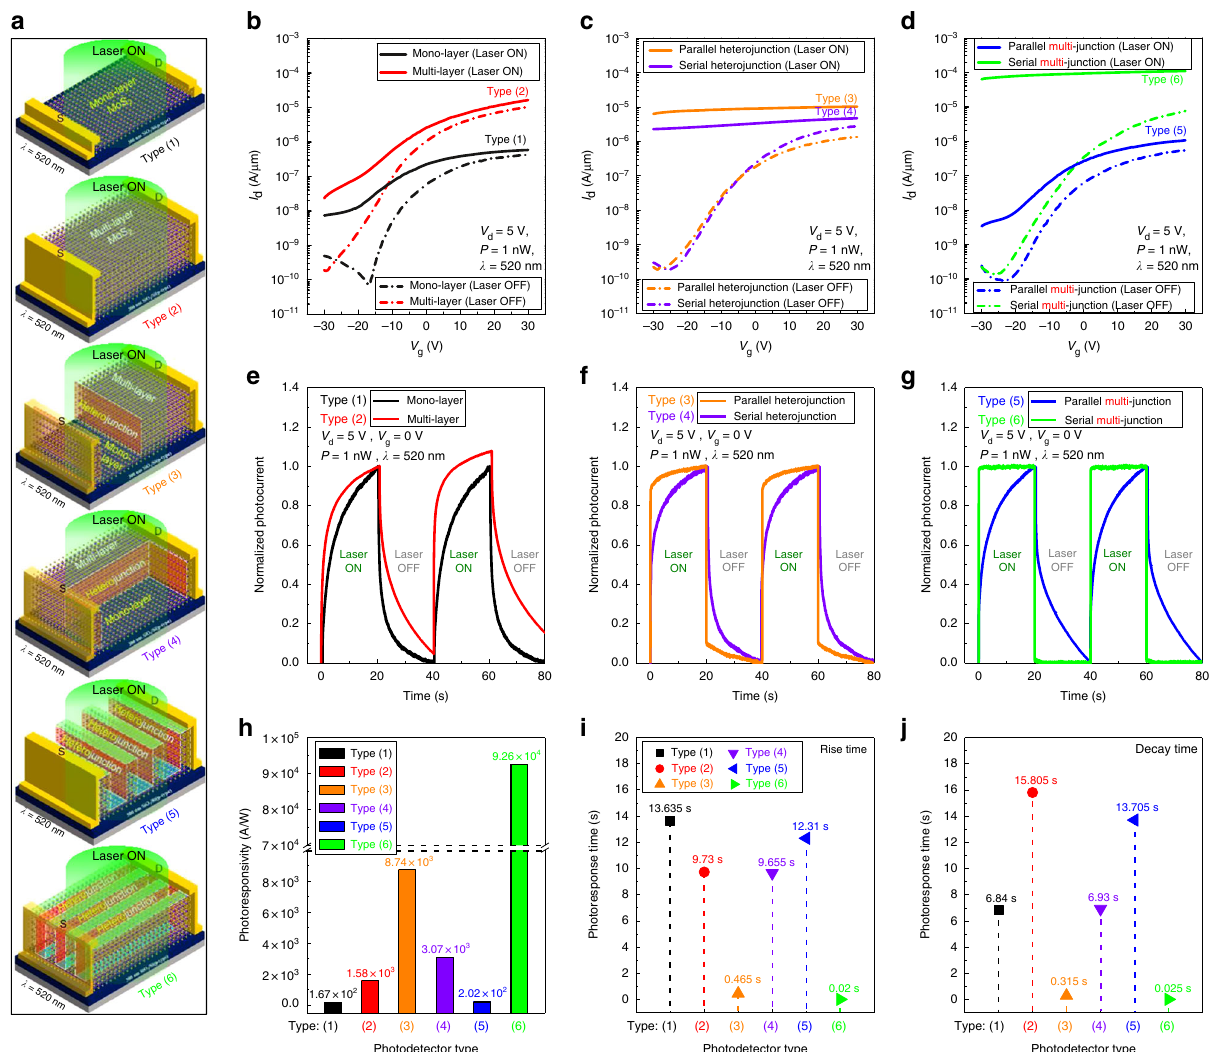
Fig. 3 Optoelectronic performance for FETs of Type (1) – (6). a Schematic diagram of Type (1) – (6) FETs (photodetectors) irradiated with a laser ( λ = 520 nm). I d – V g characteristics according to the laser on/off in b Type (1), (2), c Type (3), (4), and d Type (5), (6). The normalized photoresponse curve according to the laser on/off in e Type (1), (2), f Type (3), (4), and g Type (5), (6). h The photoresponsivity of Type (1) – (6). i Rise time and j decay time for the photoresponse of Type (1) – photoresponsivity of Type (2) [1.58 × 10 3 A/W] was ~9.46 times higher than that of Type (1) [1.67 × 10 2 A/W] due to the gen- eration of more photocarriers caused by more layers and lower exciton binding energy of the 6L-MoS 2 (~0.2 eV) compared to 1L-MoS 2 (~0.4 eV) 42 . The photoresponsivities of the pristine mono-layer and multi-layer MoS 2 were similar to those investi- gated by previous researchers 7,21 . In the case of photoresponse curve in Fig. 3e, the rise time during the laser-on time of 0 – 20 s was shorter for Type (2) [9.73 s] compared to Type (1) [13.635 s] also due to the generation of more photocarriers for the multi- layer MoS 2 . However, for the laser-off time of 20 – 40 s, due to the more remaining photocarriers (electrons and holes) not recom- bined by charge traps 43,44 and the slower electron – hole recom- bination for the indirect energy band-gap compared to the direct energy band-gap, the decay time was longer for the Type (2) [15.805 s] with the multi-layer MoS 2 compared to that of Type (1) [6.84 s]. Figure 3c, f show the I d – V g curve and the photoresponse curve, respectively, for the Type (3)-parallel heterojunction MoS 2 FET and Type (4)-serial heterojunction MoS 2 FET with the laser